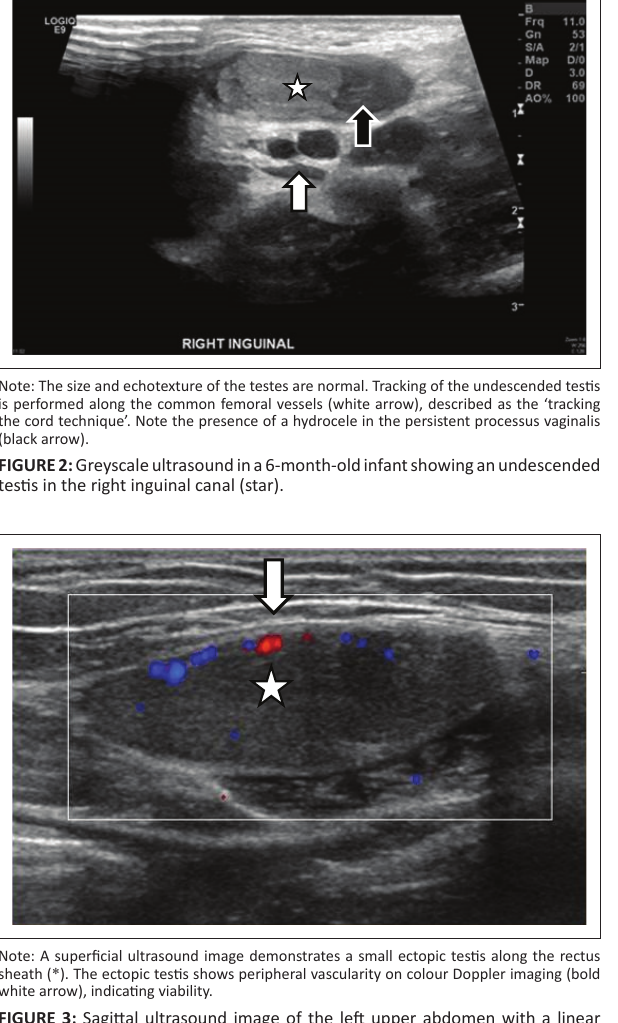
FIGURE 3: Sagittal ultrasound image of the left upper abdomen with a linear probe in a 2-year-old male child with left cryptorchidism.